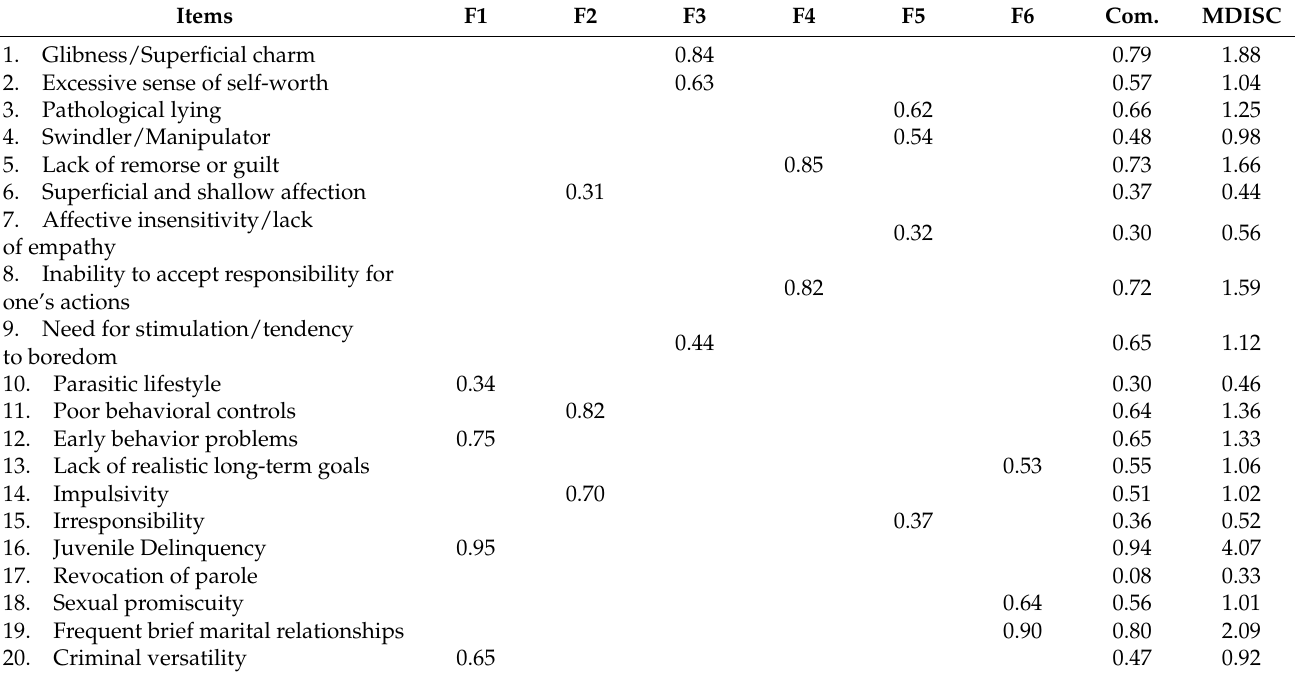
Table 1. Factorial Solution of the